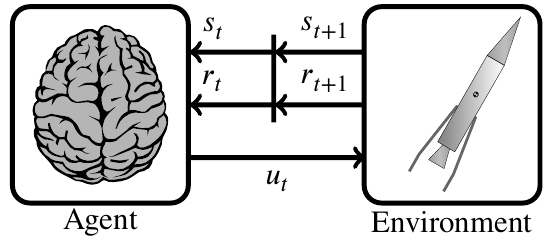
Figure 1. Conceptual reinforcement learning